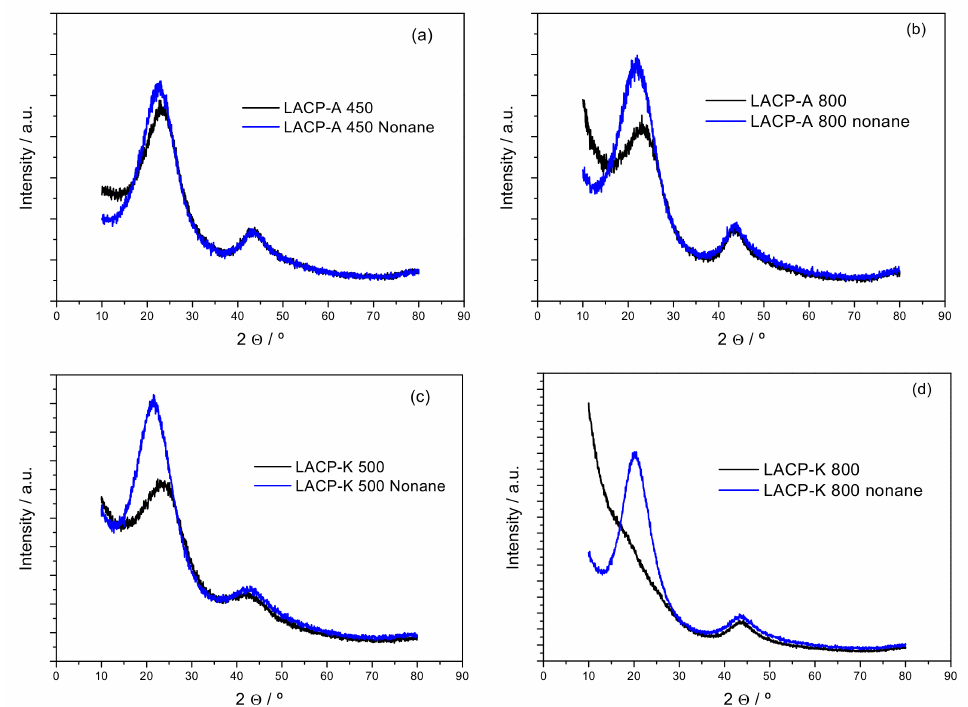
Figure 4. XRD profiles for the peach stone-based activated carbon after ( a , b ) acid (LACP-A) and ( c , d ) KOH (LACP-K) activation prepared at ( a , c ) low and ( b , d ) high activation temperature, and before and after incorporation of di ff erent